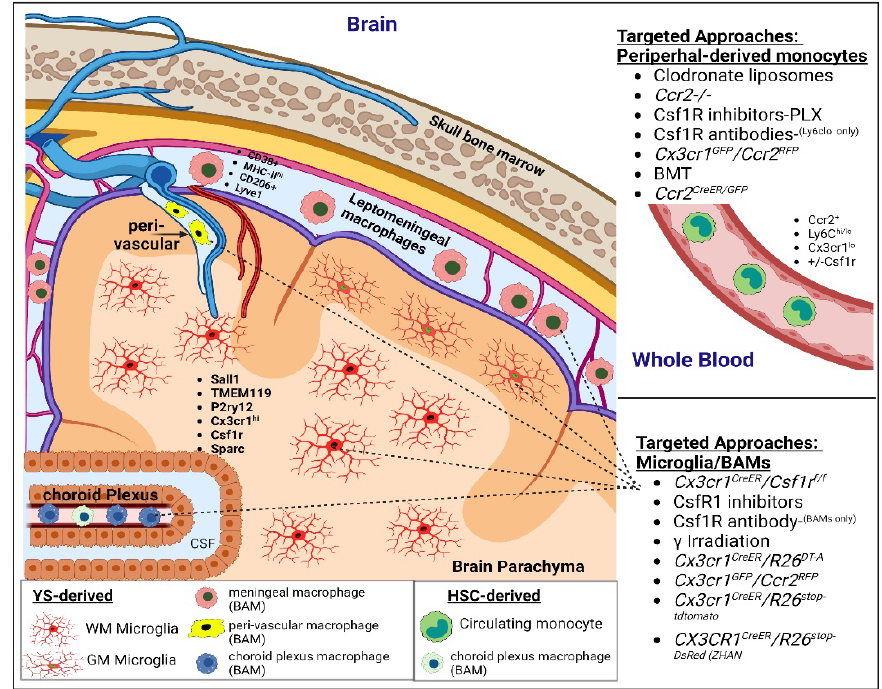
Figure 1. Peripheral-derived monocytes, microglia, and CNS border-associated macrophages (BAMs). Regional presence and experimental approaches used to target CNS macrophages vs. circulating monocytes. Lineage tracing and scRNAseq have been instrumental in understanding the phenotypic spectrum and subpopulations of resident vs. CNS-infiltrating macrophages. (YS—yolk-sac, BAM—border-associated macrophages, GM ؙ — grey matter, WM—white matter, HSC—hemato- poietic stem cells, BMT—bone marrow transplant).